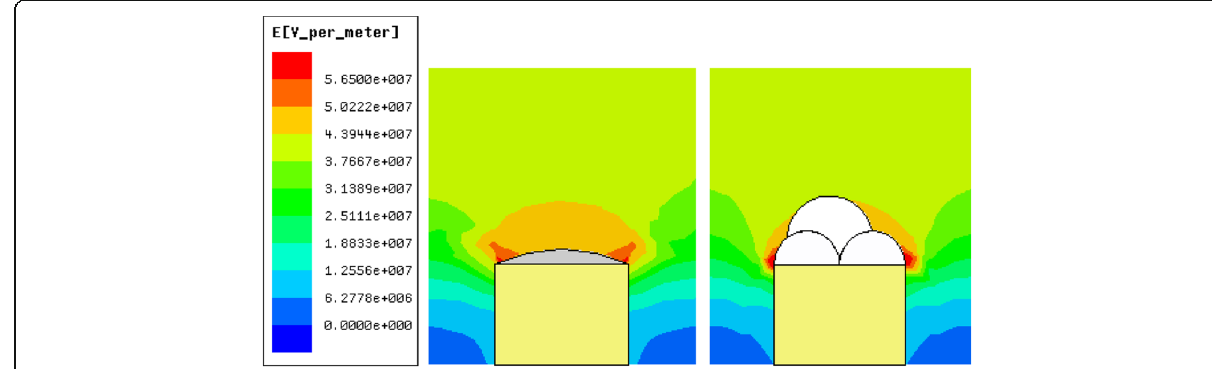
Fig. 9 Simulation of electric field distributions at 60 kV (working distance 13 cm). a around the free surface. b around the